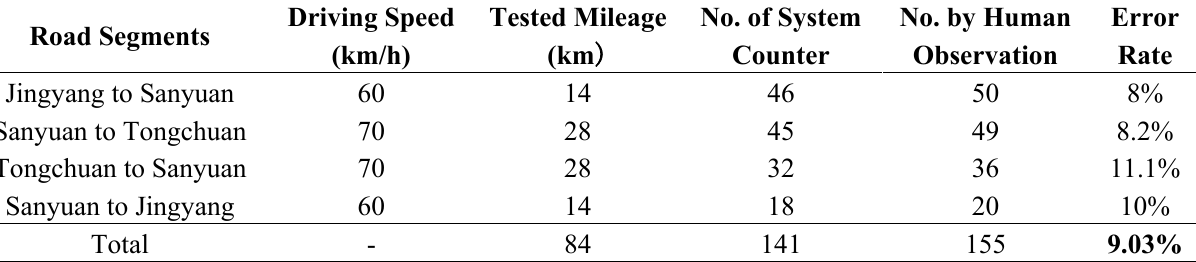
Table 2. Experimental results without signal strength on 7 June